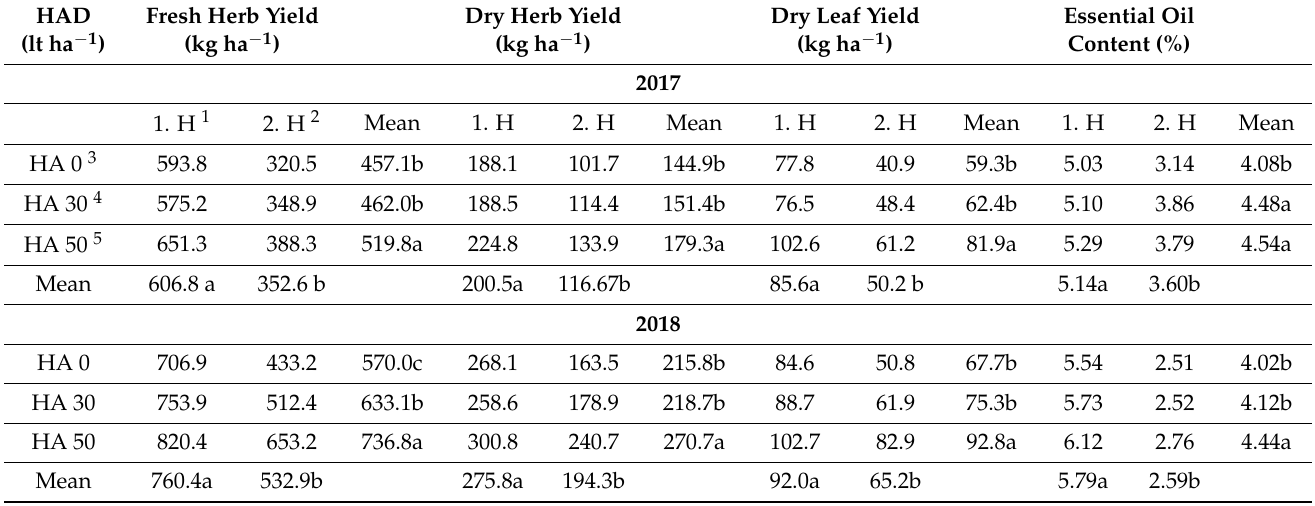
Table 3. Effects of HAD and HT on fresh herb yield (kg ha − 1 ), dry herb yield (kg ha − 1 ) and dry leaf yield (kg ha − 1 ) of O. vulgare subsp. hirtum L. in 2017 and 2018.